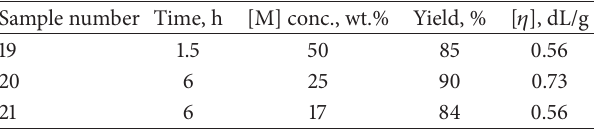
— — ∗ Here and further, the value corresponds to MW of a major eluted peak related to preliminary built calibration curve (polystyrene standards). Conditions: [M]/[E] = 10/1wt./wt., [PDL] = 50wt.%. Table 5: Dependences of polyPDL yield, reaction time (visual fixation of polymerization mixture solidification), and product intrinsic viscosity on monomer